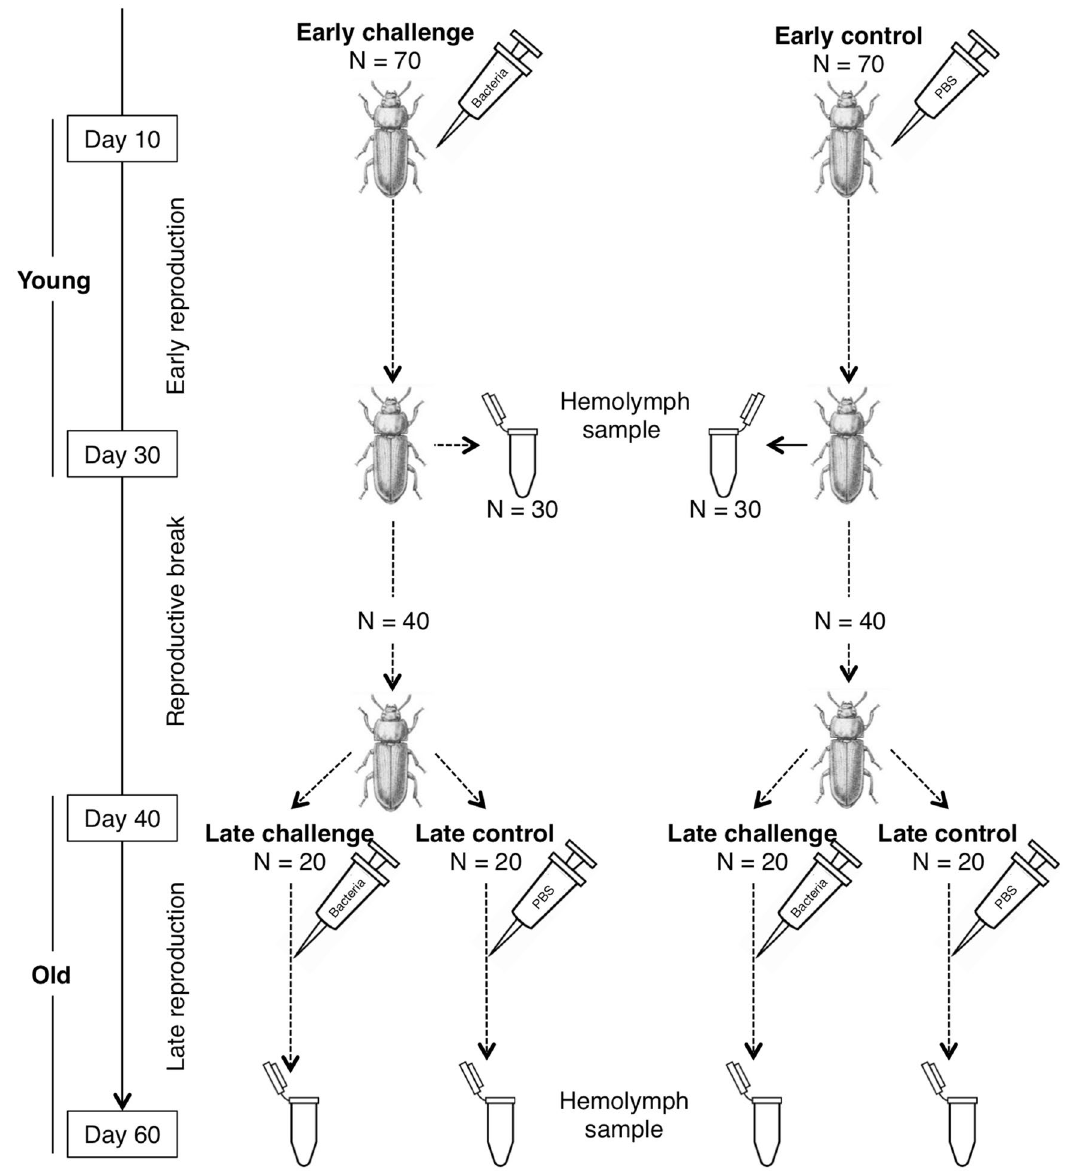
Figure 1. The experimental protocol used to study the effect of an age-specific immune challenge on the immune defences and reproduction of females of the mealworm beetle ( Tenebrio molitor ).